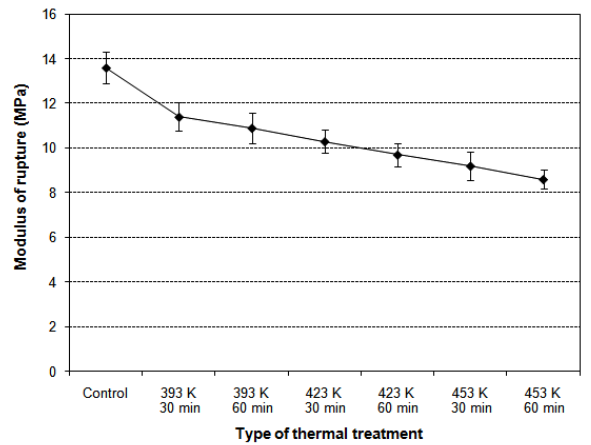
Figure 2. Effect of the thermal treatment of the wood fibers of E. camaldulensis on the modulus of rupture of the light MDF panels. The vertical lines through the bars represent the standard deviation from the average value of fourteen samples.